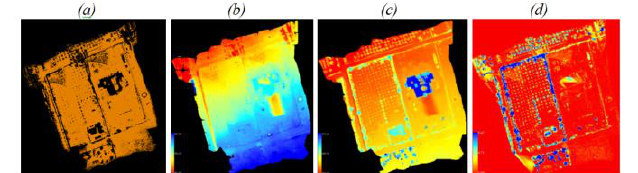
Figure 4 . Processing Results of LiDAR Data: (a) Classification, (b) DTM, (c) DSM, (d) DCM